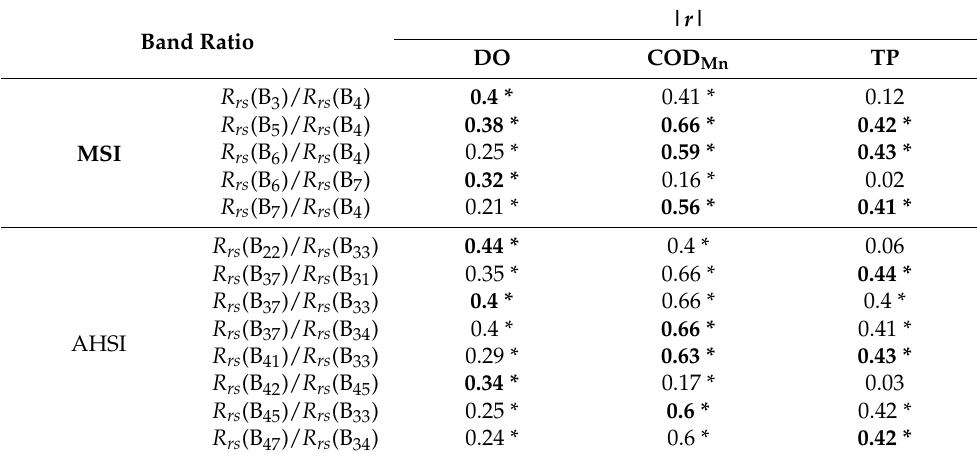
Table 4. The absolute value of r and p -value between water quality parameters and MSI and AHSI equivalent reflectance ratios.